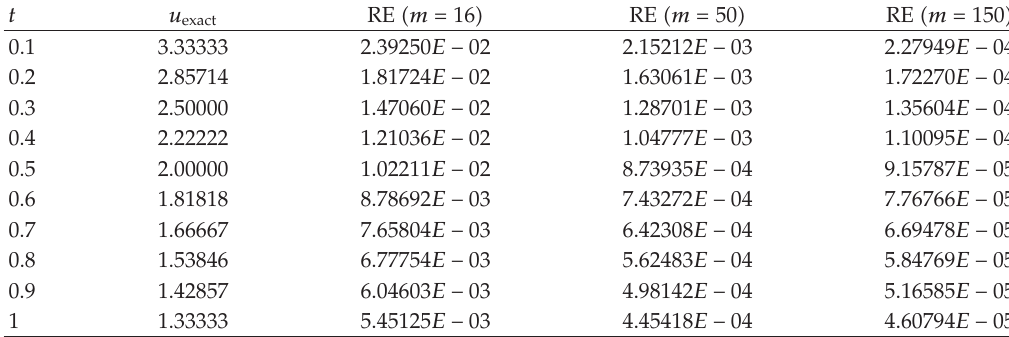
(cid:3) t (cid:4) , for Example 4 ,m